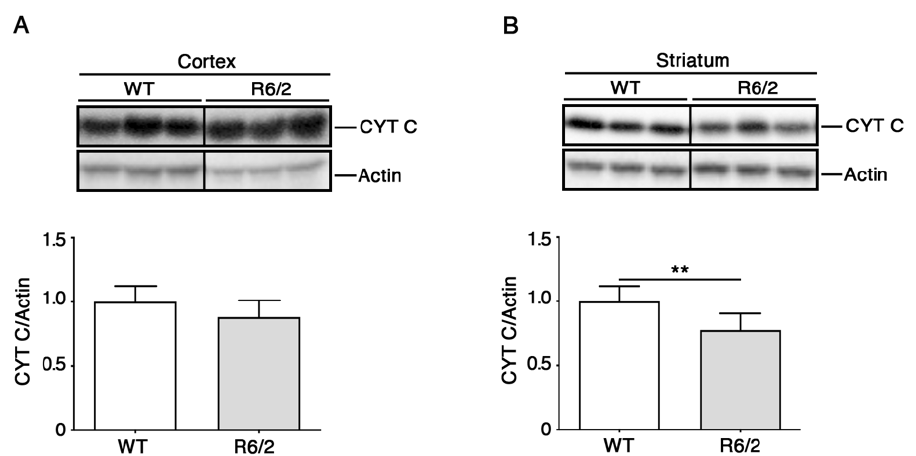
Figure 4. Altered cytochrome c (CYT C) levels in brain tissues of 11-week-old R6/2 mice. Representative cropped immunoblotting and densitometric analysis of cytochrome levels in cortical ( A ) and striatal ( B ) tissues from 11-week-old R6/2 mice and WT controls. In each immunoblotting, all samples were run on the same gel. Non-adjacent samples were separated by a black line. N = 7 for each group of mice. Data are represented as mean ± SD. ** p < 0.01 (Unpaired t -test). The raw data used for generating the figure are reported in Supplementary Materials Table S4.